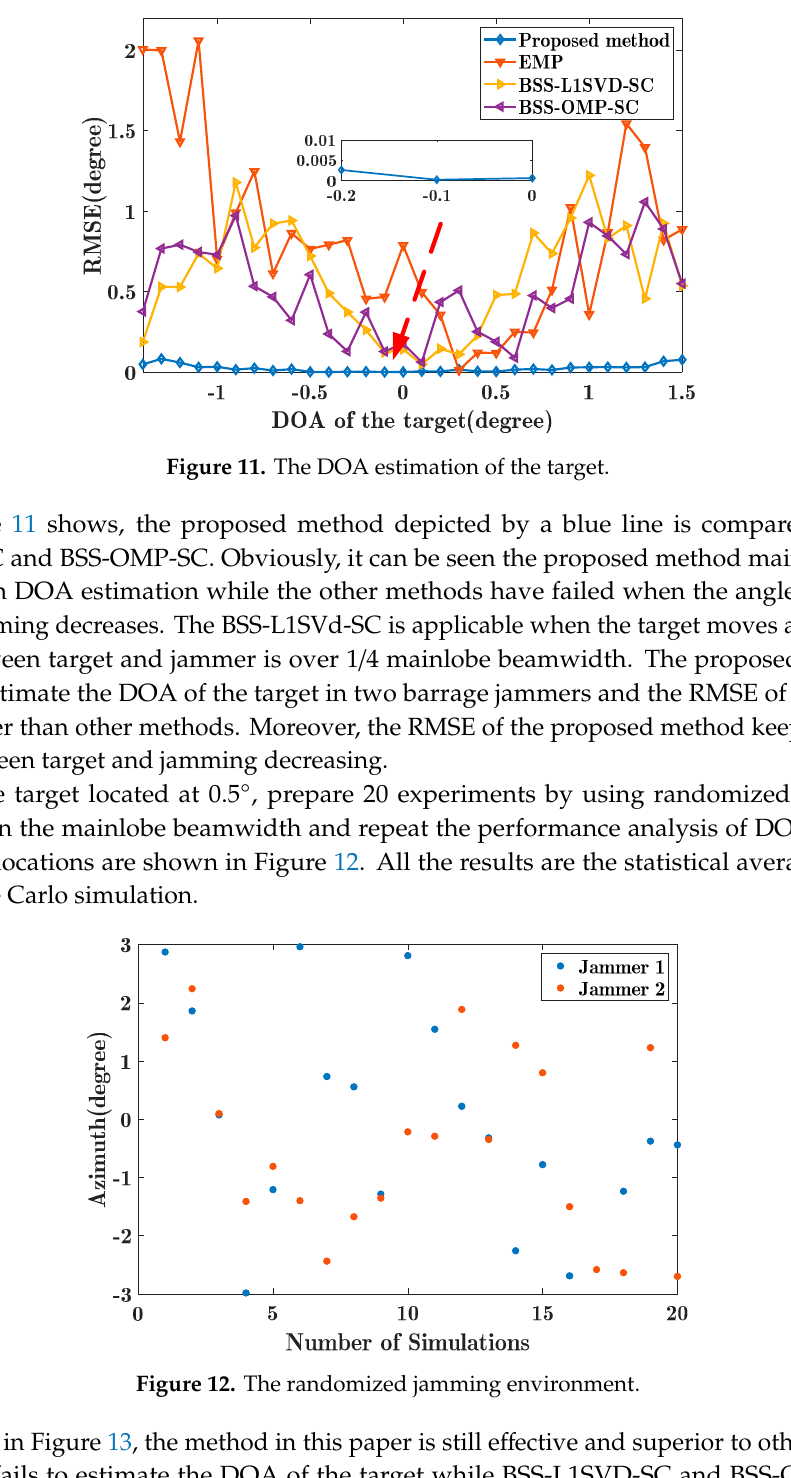
Figure 10. The jamming environment.